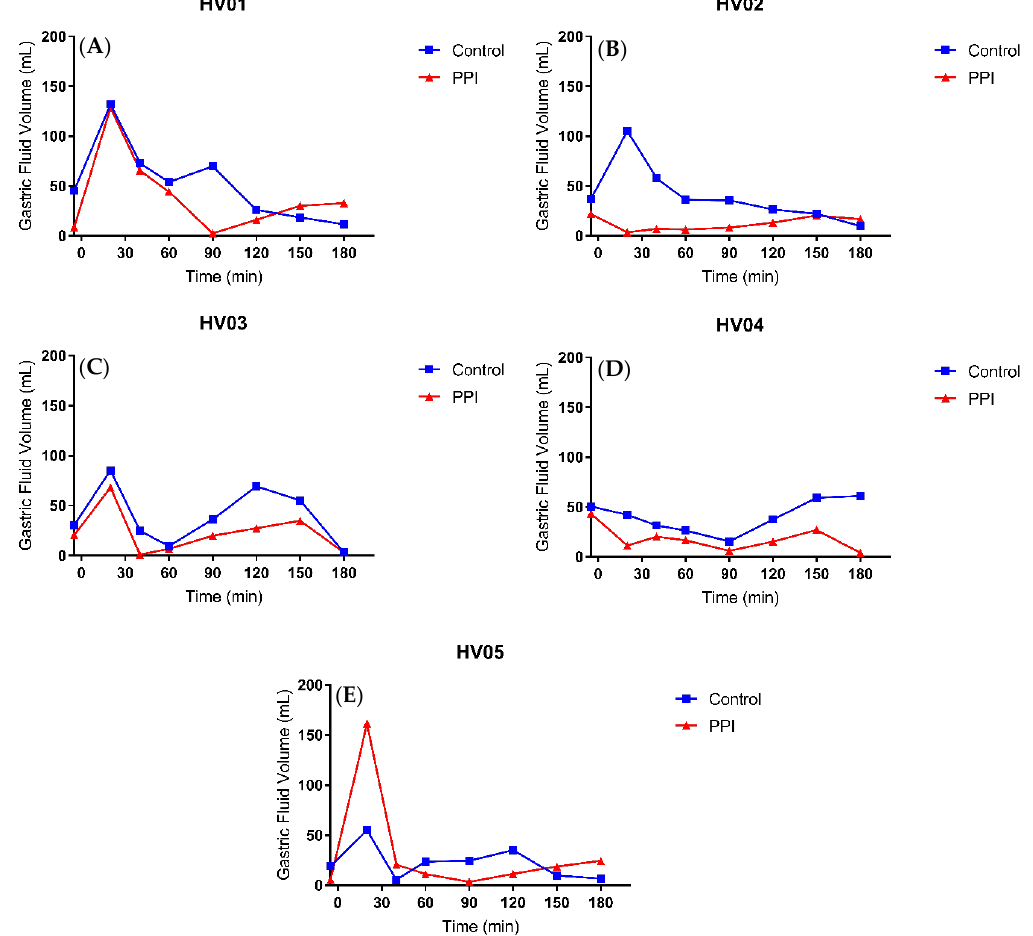
Figure 7. Individual gastric fluid volume over time profiles for ( A ) HV01, ( B ) HV02, ( C ) HV03, ( D ) HV04 and ( E ) HV05 following oral intake of a Norvir tablet with 240 mL water in control (blue squares) versus PPI condition (red triangles).